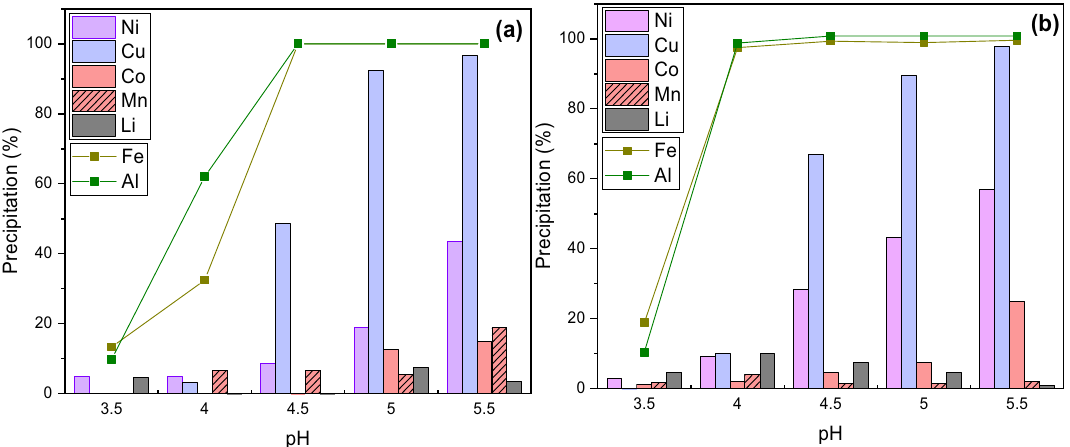
Figure 1. Precipitation using NaOH at ( a )* 30 °C and ( b ) 60 °C with 4 g/L of Al in the solution (*based on solution analysis using Eq.